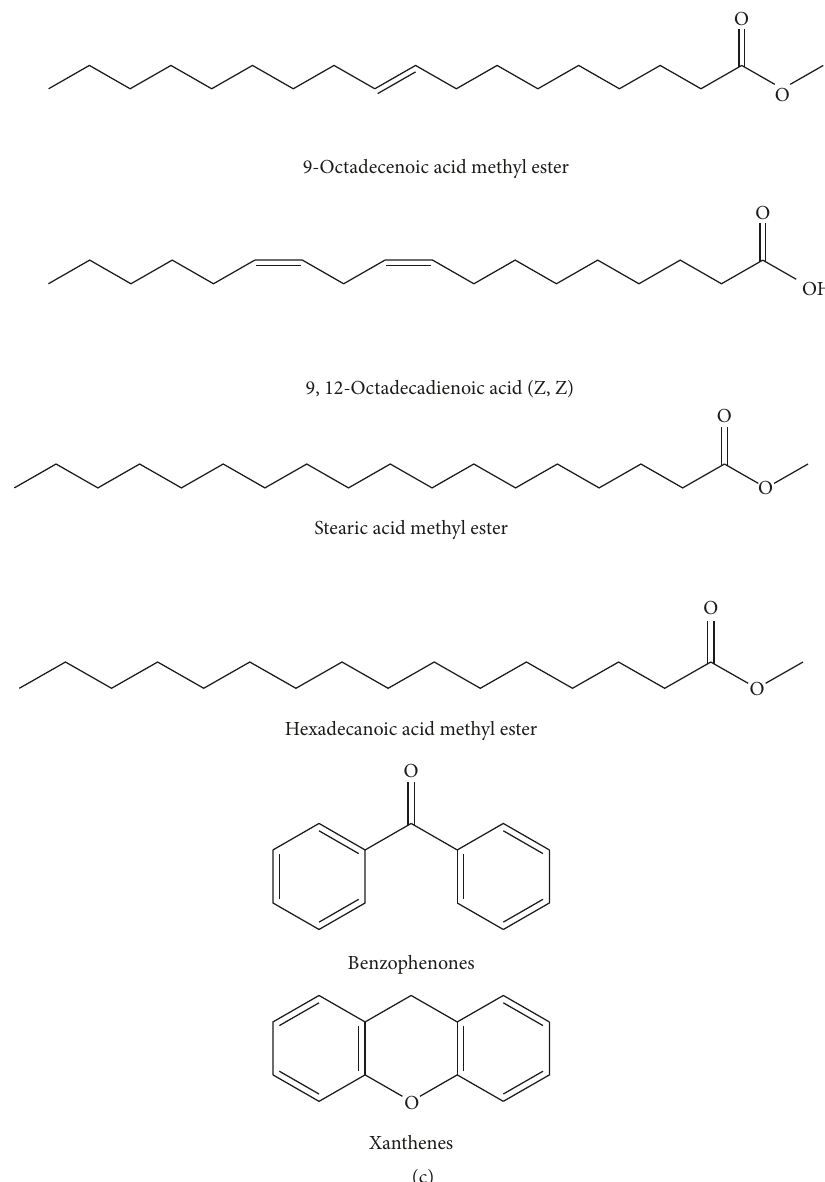
Figure 2: Some of the chemical structures found in G. kola are responsible for its biological